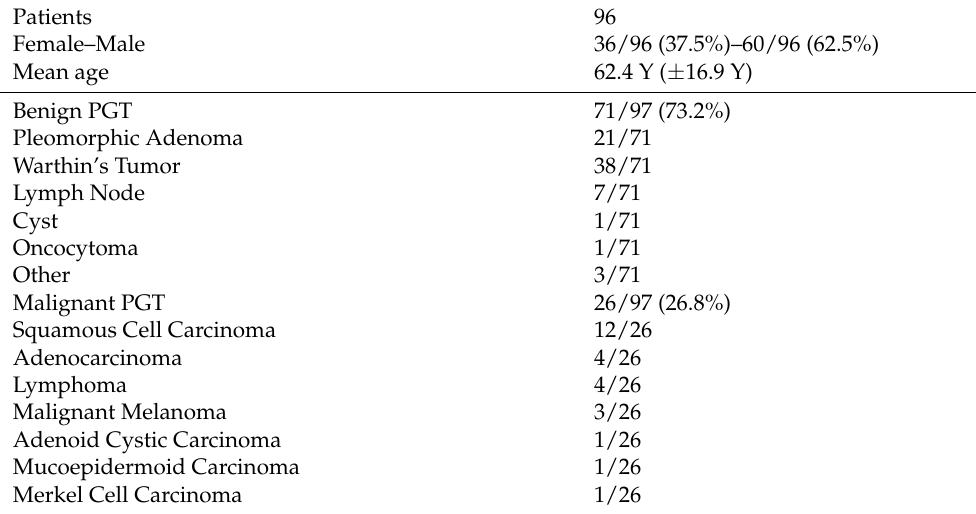
Table 1. Study population. Continuous variables are given as mean (SD), categorical variables are given as absolute/total numbers (n/N), and percentages are in brackets. Abbrevations: PGT denotes parotid gland tumors.